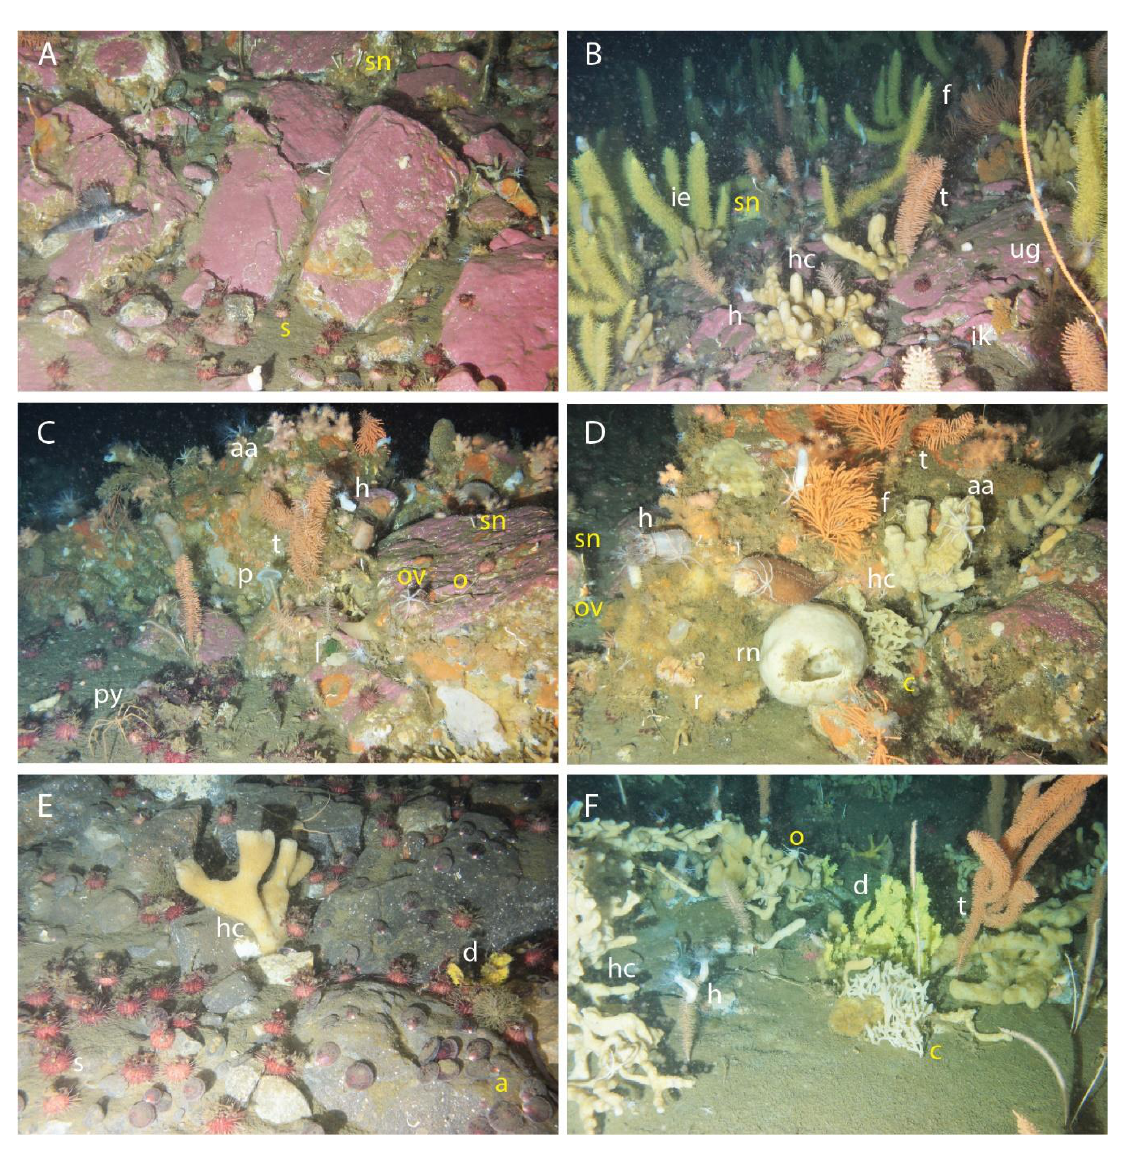
Figure 3. Benthic assemblages at Adélie Cove. ( A ) Hard substrate with pebble and boulders encrusted by coralline algae ( Hapalidiales spp.) at 76 m with the echinoid Sterechinus neumayeri (s) and the serpulid Serpula narconensis (sn); ( B ) Assemblage dominated by the sponges Isodyctia erinacea (ie), Isodyctia kerguelensis (ik) and specimens belonging to the genus Haliclona (hc) colonizing hard substrate covered by coralline algae at 82 m, with the subordinate presence of Serpula narconensis (sn), cnidarians such as Fannyella rossii (Gray, 1872) (f), specimens of the genus Thouarella (t) and Unbranched gorgonians (ug) and individuals of Holothutoidea spp. (h). ( C ) The portion of seafloor at 99 m dominated by cnidarians of genus Thouarella (t) and Alcyonium antarcticum (aa), with polychaetes Serpula narconensis (sn) and Perkinsiana magalhaensis (p), echinoderms such as Ophiacantha vivipara (Ljungman, 1871) (ov), Ophiuroidea sp. (o) and Holothuroidea sp. (h) and Chelicerata pycnogonida sp. (py); note the presence of the sponge Latrunculia biformis (l) ( D ) assemblage dominated by cnidarians at 100 m including Fannyella rossii (f), Alcyonium antacticus (aa) and specimens of genus Thouarella (t) and subordinately by sponges represented by Rossella nuda (rn), Haliclona sp. (h) and individuals of class Calcarea (c), with the presence of the serpulid Serpula narconensis (sn), bryozoans belonging to genus Reteporella (r), Ophiuroidea such as Ophiacantha vivipara (ov) and Ophiuroidea sp. (o) and Holothuroidea sp. (h); ( E ) aggregations of the echinoid Sterechinus neumayeri (s) and the pectinid Adamussium colbecki (a) at 82 m with sponges Dendrilla membranosa (d) and Haliclona sp. (hc); ( F ) seafloor dominated by sponges at 112 m comprising D. membranosa (d) and specimens of genus Haliclona (hc) and class Calcarea (c), with sporadic presence of cnidarians of genus Thouarella (t) and echinoderms belonging to Ophiuroidea (o) and class Holothuroidea (h); observe the lack of coralline algae ( Hapalidieles spp.) cover. Yellow letters refer to calcifier fauna.